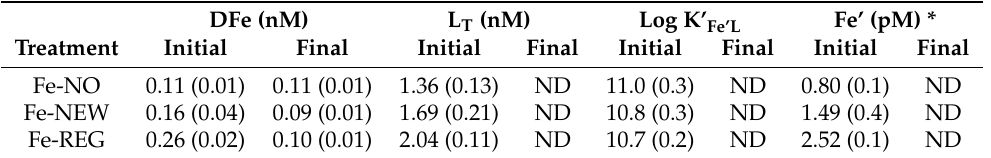
Table 1. Initial and final concentrations in dissolved iron (DFe), inorganic Fe (Fe’), total iron-binding ligand (L T ), and conditional stability constants (log K’ Fe’L ). Values within parentheses are the standard deviation of the mean of three measurements. ‘ND’ denotes no